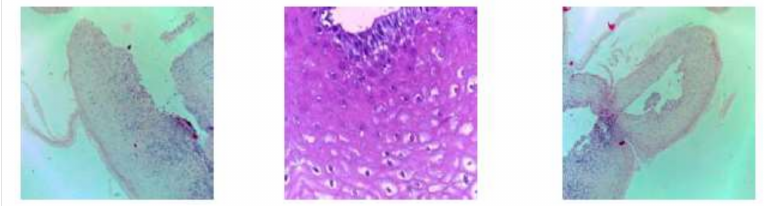
Figure 3. Pre-processed (227 × 227) oral squamous cell carcinoma biopsy